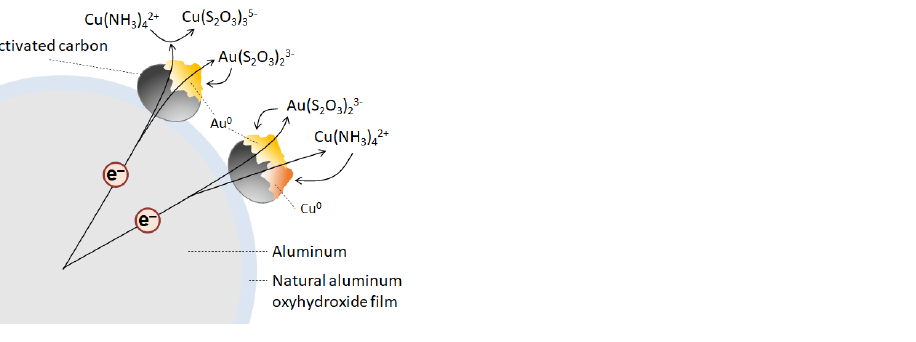
Figure 3. Schematic diagram of the competitive electron transfer from ZVAl to the Cu complex and the Au-thiosulfate complex.